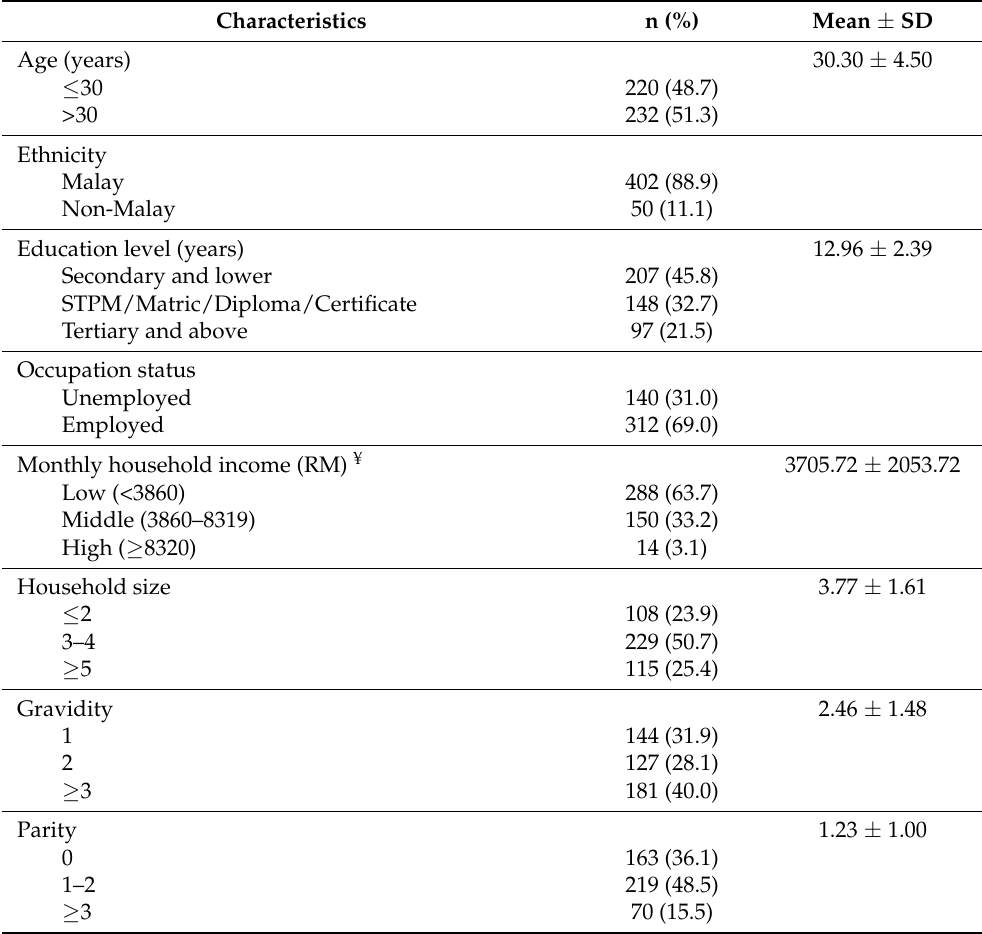
Table 2. Characteristics of women (N =